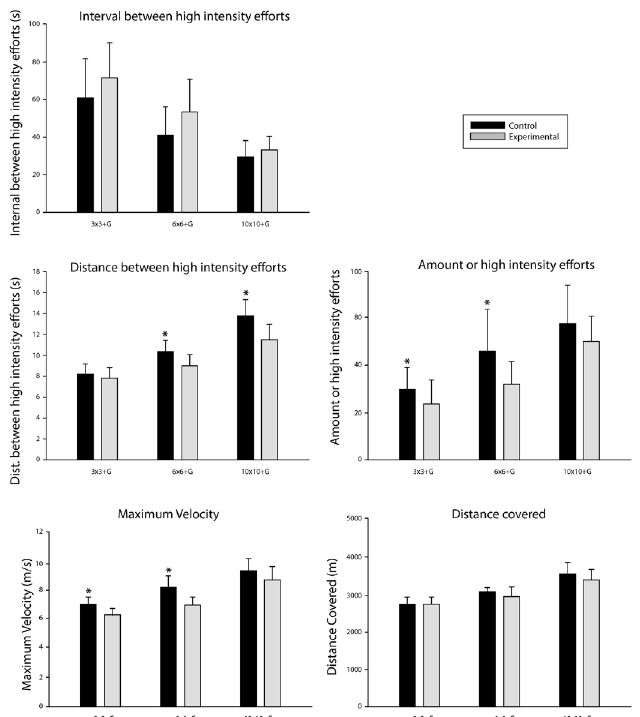
Figure 2. Comparison of the physical variables between the control and the experimental fields in the same field